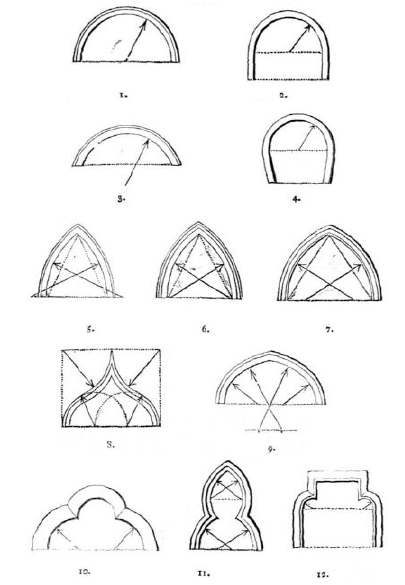
Figure 1. Several different types of arches used in gothic architecture (Bloxam, 1882). Arches